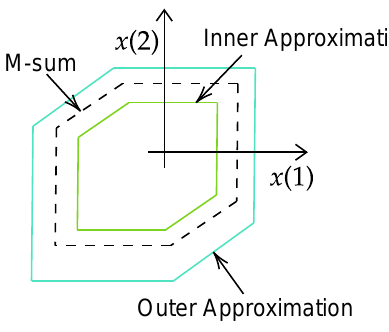
Figure 2. Sketch of the aggregation space: exact aggregation (M-sum), inner approximation, and outer